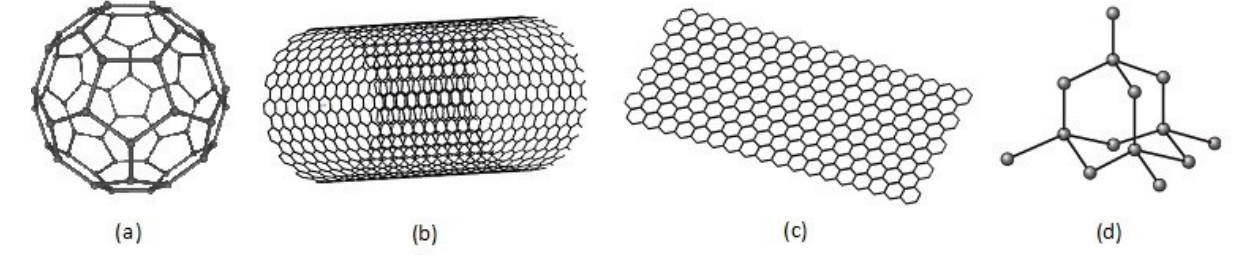
Figure 2: Different types of carbon nanostructures: (a) fullerene (b) nanotube (c) graphene sheet (d) diamond